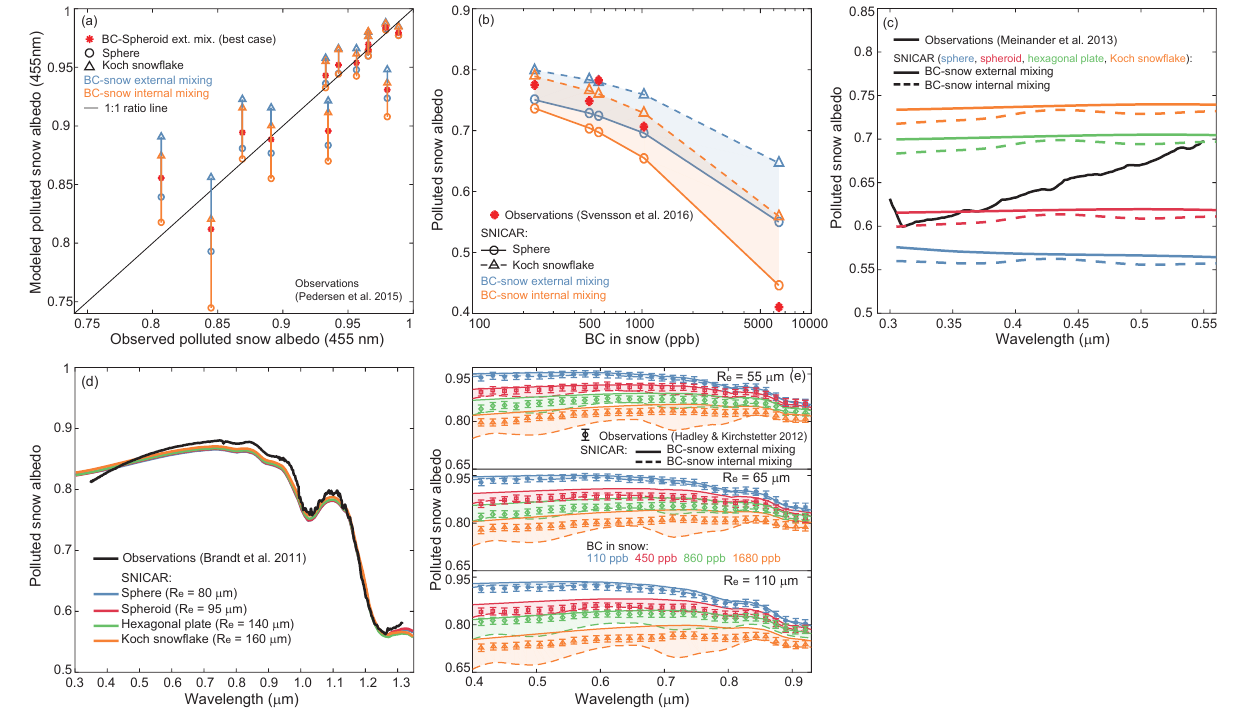
Figure 7. Comparisons of BC-polluted snow albedo from observations and SNICAR simulations using observed snowpack properties (see Table 1 and text for details). (a) Observations ( x axis) are obtained from field measurements in the Arctic (Pedersen et al., 2015). Model re- sults ( y axis) for spheres (circles) and Koch snowflake (triangles) are shown as lower and upper limits for shape effects, along with BC–snow external (blue) and internal (orange) mixing. Also shown is the best case (red asterisks; BC-spheroid external mixing) that matches observa- tions. (b) Observations (red asterisks; broadband albedo for 0.285–2.8µm) are obtained from open-field experiments in Finland (Svensson et al., 2016). Model results for spheres (circles) and Koch snowflake (triangles) are shown as lower and upper limits for shape effects, along with BC–snow external (blue) and internal (orange) mixing. (c) Observations (black lines) are obtained from field measurements in the European Arctic (Meinander et al., 2013). Model results assuming sphere (blue), spheroid (red), hexagonal plate (green), and Koch snowflake (orange) along with BC–snow external (dashed lines) and internal (solid lines) are shown. (d) Observations (black) are obtained from open-field exper- iments in New York (Brandt et al., 2011). BC is assumed to be externally mixed with snow spheres (blue), spheroids (red), hexagonal plates (green), and Koch snowflakes (orange). The effective radii ( R e ) for each snow shape are obtained to best match observations at wavelengths of 1–1.3µm. (e) Observations (circles) are obtained from laboratory measurements (Hadley and Kirchstetter, 2012). BC is assumed to be externally (solid lines) and internally (dashed lines) mixed with snow spheres.